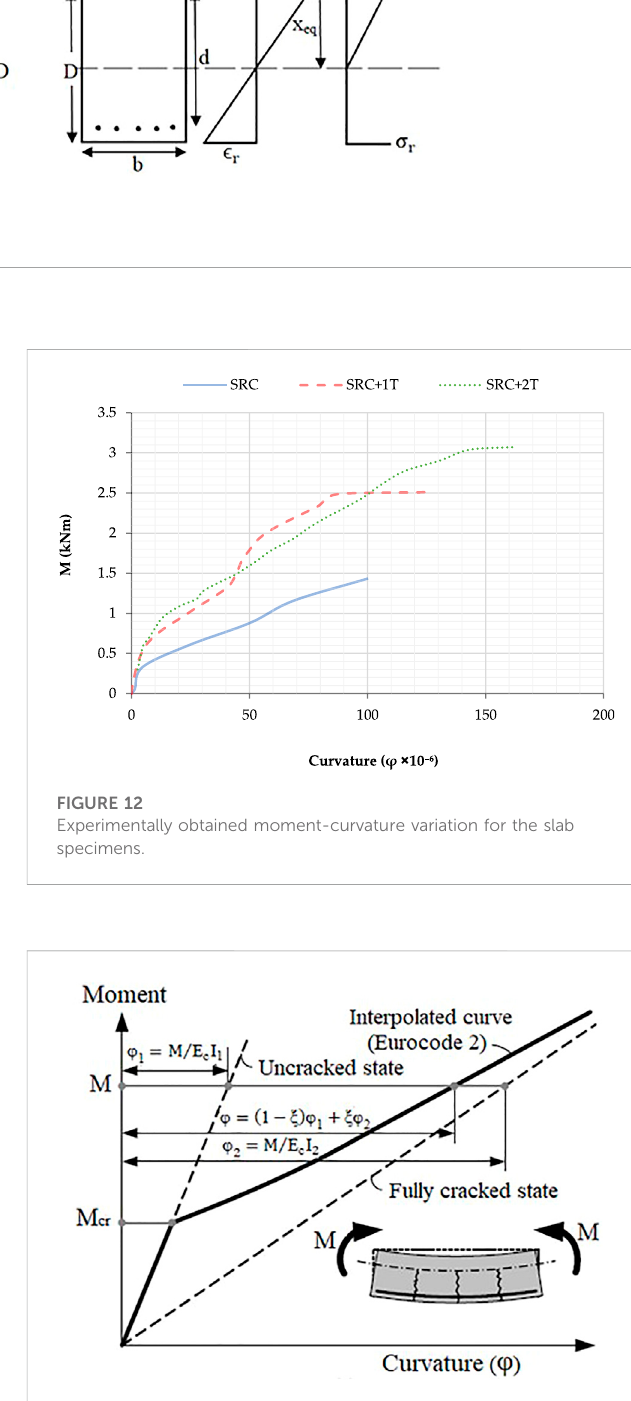
FIGURE 13 Moment-curvature relation as per Eurocode 2 (redrawn from (Institution,